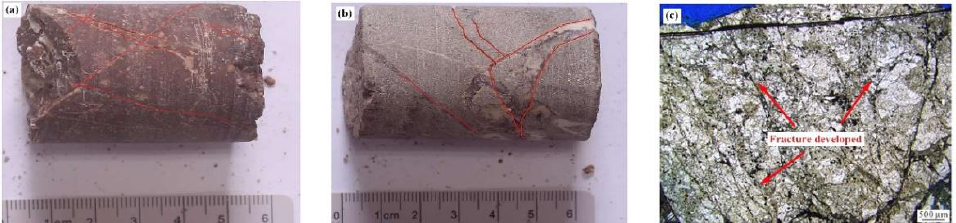
Figure 2. The typical core photographs and slice microscopic. (a), (b) The core photographs, frac- ture developed, be partially filled; (c) Slice microscopic, fracture developed.